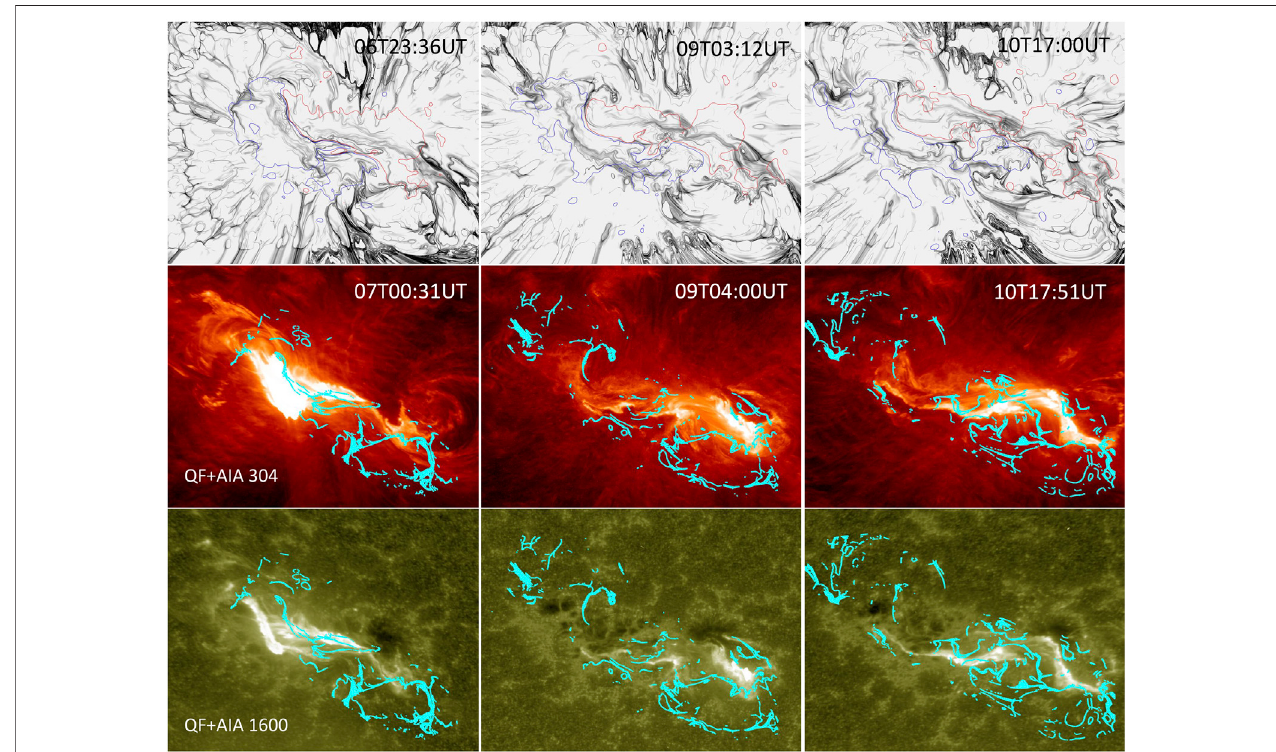
FIGURE 6 | Comparison of QSLs and fl are ribbons for the pre-eruptive magnetic structure of CME1 ( fi rst column), CME2 (second column), CME3 (third column) in theAR11429. Firstrow: InversemapsofLog( Q )obtainedat z (cid:1) 1.5 Mm . B z -contoursat ± 120 Gareoverdrawn(red/bluecurves).QSLswithlargeQvaluesareidenti fi ed by intense black traces in strong fi eld region. All maps are scaled within 1 < Log( Q ) < 7. QSLs of large Q-values separate the sheared/twisted core fi eld from the surrounding less sheared fi eld in the following bipolar region. Also higher Q-values in quiet regions are due to noisy transverse fi eld and have no relevance to the magnetic structure of interest. Second and third rows: Co-spatiality of QSLs and fl are ribbons. Contours of Log( Q ) (cid:1) [4,5,6] (in cyan color) on AIA 304 Å (second row) and AIA 1600 Å (third row) snapshots taken at around the peak fl are time. QSLs are co-spatial with the fl are ribbons including the hooked